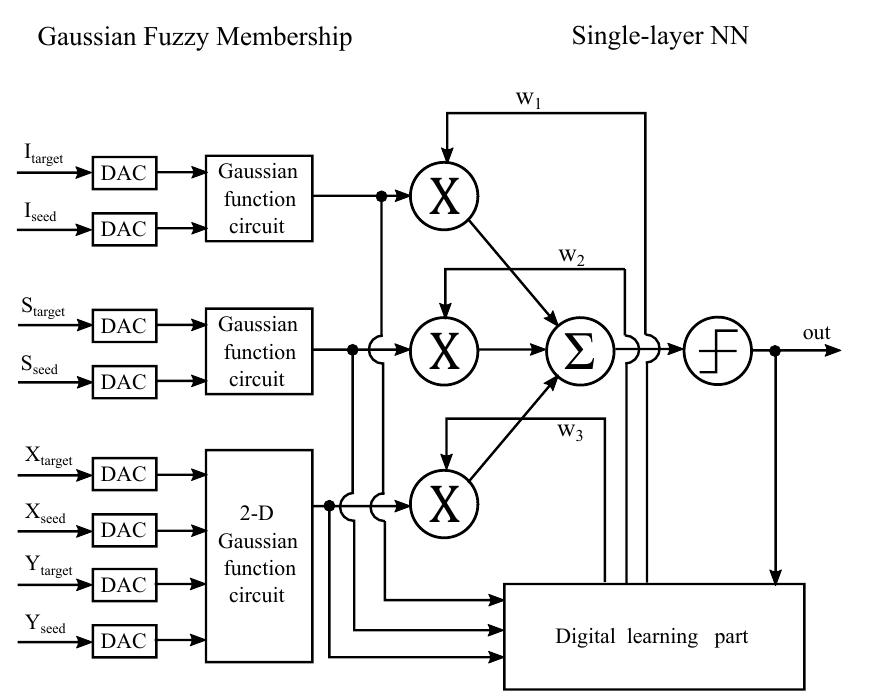
Figure 43. An example of a shallow Neuro-Fuzzy Radial Basis Function Neural Network.